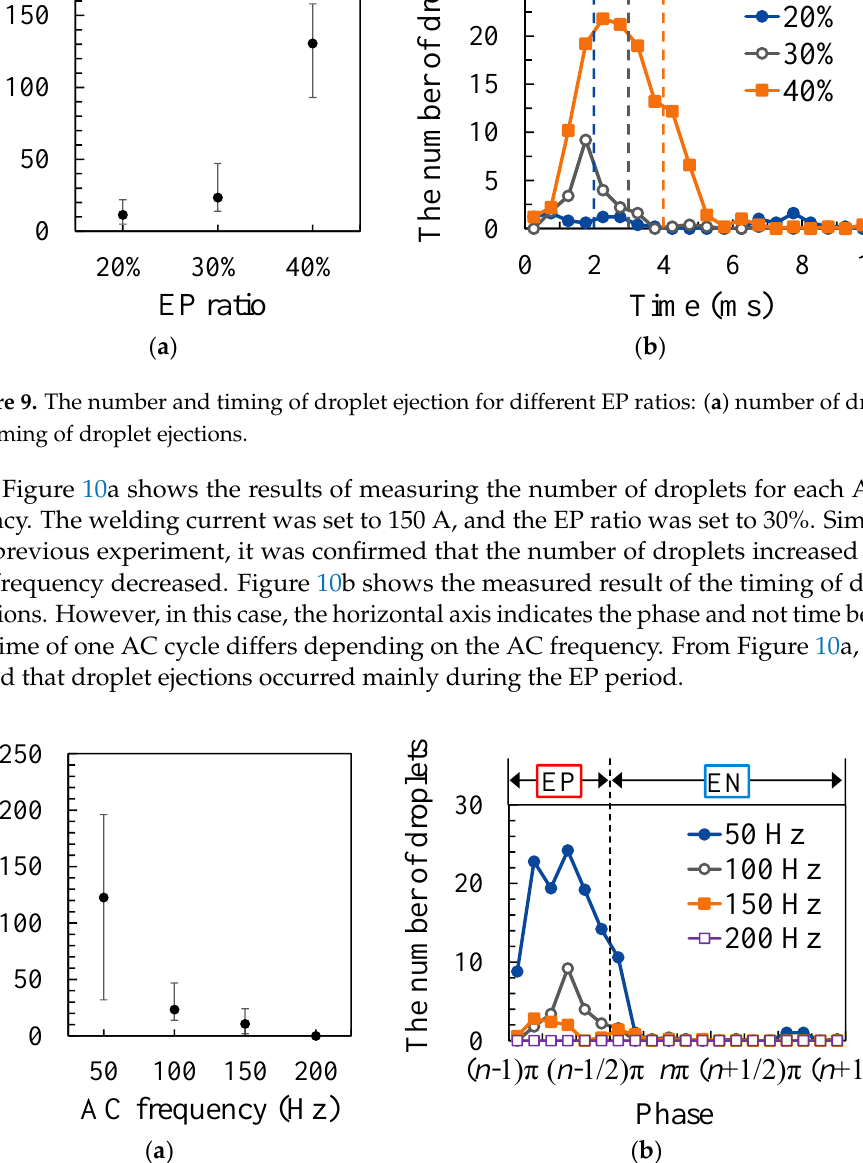
( b ) Figure 8. The number and timing of droplet ejection for different welding currents: ( a ) number of